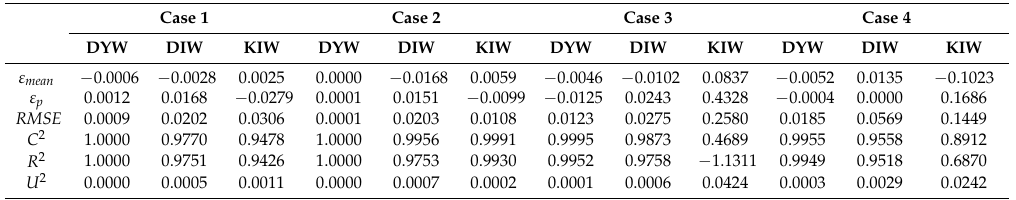
Table 4. Error calculations obtained from the CAMP1DF DYW/DIW/KIW simulations and analytical results by MacDonald et al. (1997)